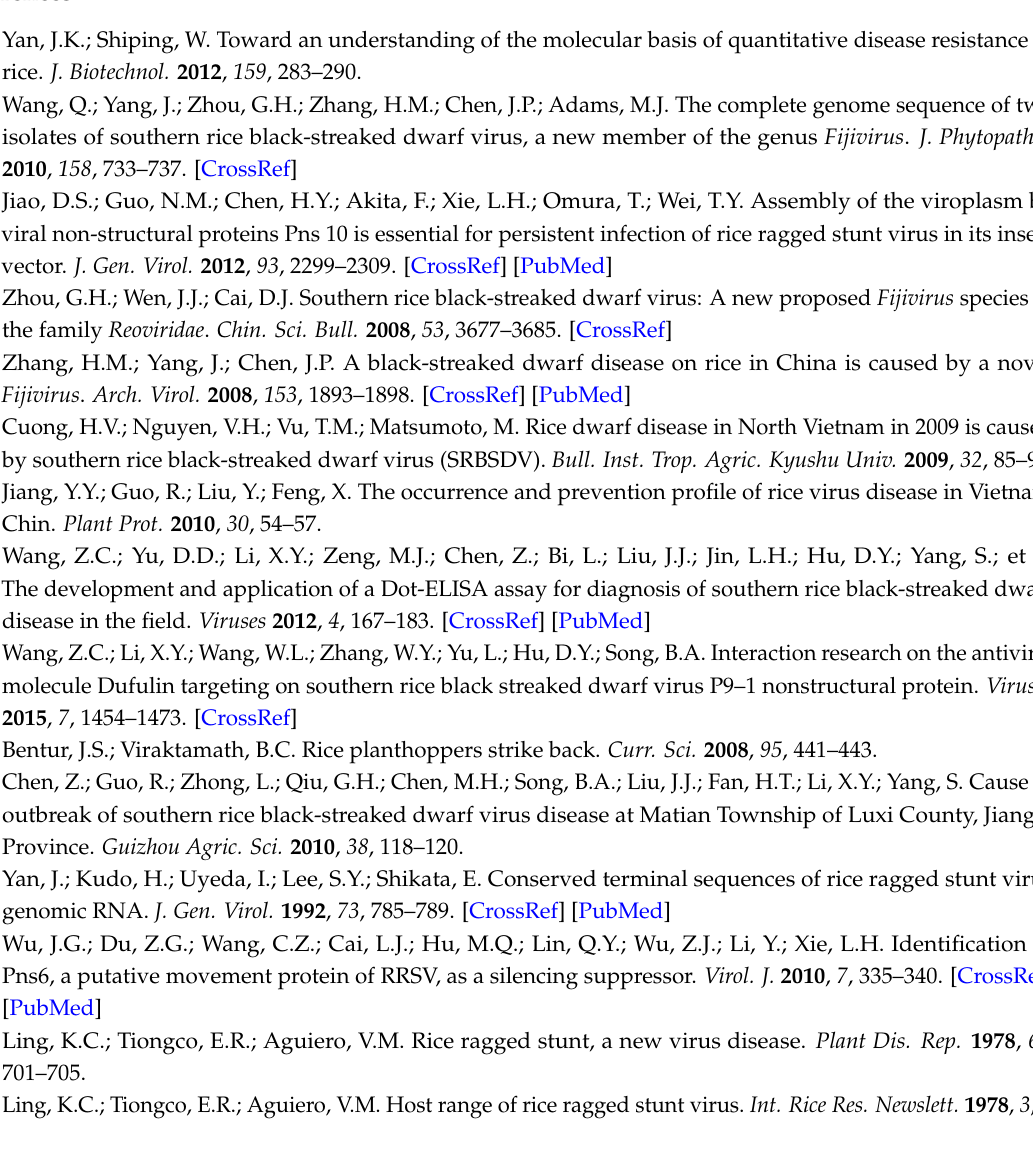
Figure S1: Detection for specificity of primers designed for SRBSDV by conventional PCR, Figure S2: Detection for specificity of primers designed for RRSV by conventional PCR, Figure S3: Hierarchical clustering analysis of differentially expressed proteins in Z1, L2186, and FYXZ. Table S1: Primers used for the expression level analysis Table S4: The differential expression